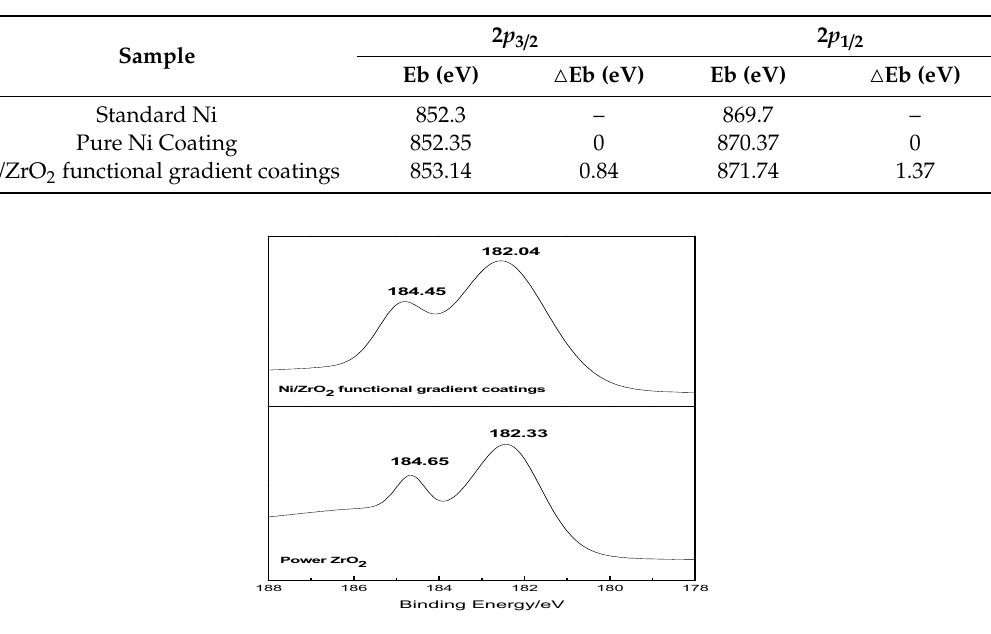
Figure 15. XPS spectrum of Zr element.